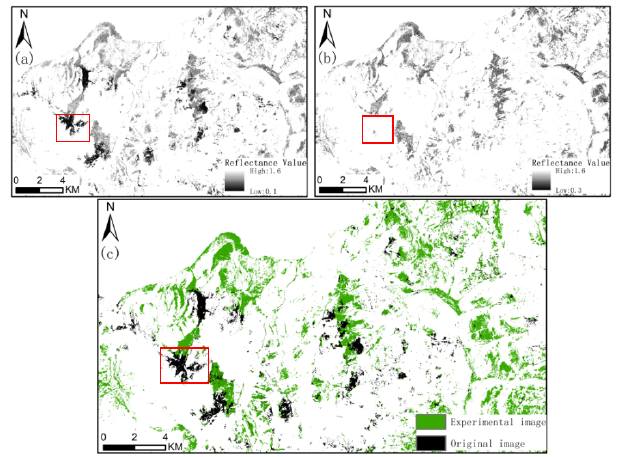
Figure 9. An example of the process of eliminating the erroneous pixels in a Sentinel-2 image. ( a ) Original image, where the pixels in the red frame are under the shadow of clouds; ( b ) experi- mental image, with no pixels in the red frame; ( c ) comparison image, where the pixels in the red frame are eliminated. By comparing Figure 10 and Table 3, it can be seen that, compared with the correc- tion of the image with erroneous pixels before the elimination, the R 2 values of the re- gression equation established by the correction after the eliminate are improved, the apparent re fl ectance sca tt er lines are all close to the 1:1 line, and the RMSE also de- creased signi fi cantly. It shows that the correction after eliminating the erroneous pixels can improve the consistency between the images, which indirectly proves the necessity of eliminating the erroneous pixels. Figure 10 shows a comparison of the sca tt er distri- bution using the apparent re fl ectance of Sentinel-2 MSI on 26 April as the independent variable and the apparent re fl ectance of Sentinel-2 MSI on 21 April as the dependent variable, where N is the number of image pixels, the black dashed line is the 1:1 line and the red solid line is the regression line of the sca tt er plot. ( a ) ( b )